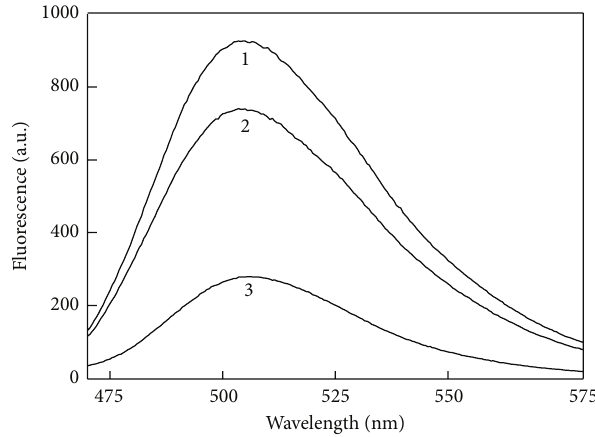
Figure 2: Fluorescence spectra of trypaflavine ( 𝜆 aqueous solutions: (1) prior to sorption, (2) after sorption on the CDA fibers, and (3) on the CDA fibers.